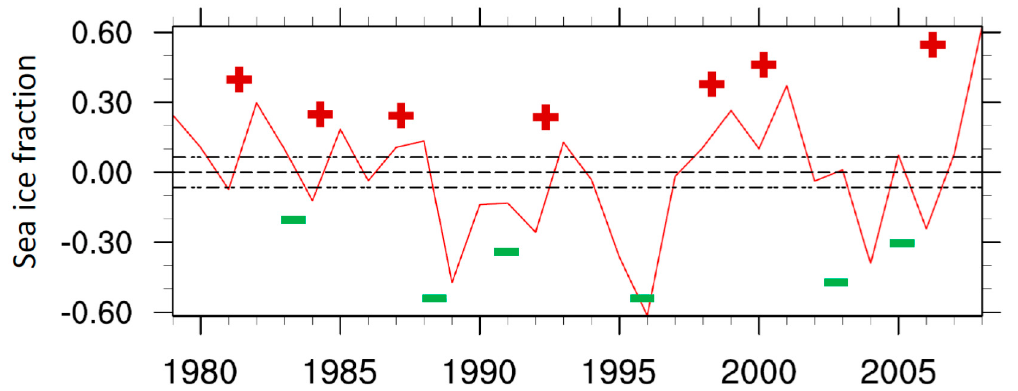
Figure 3. Detrended Arctic sea ice time series for MAM. ± showing the positive and negative extreme (above or below ±0.5 σ ) years for the composite analysis respectively.